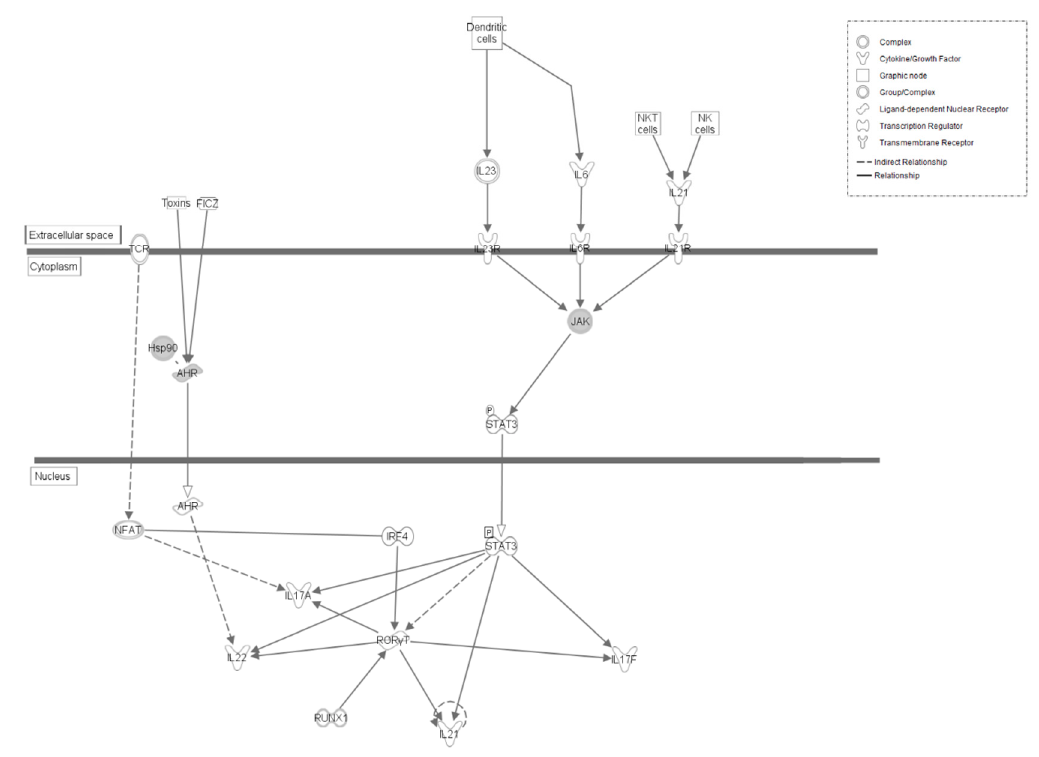
Figure 4. Th17 Activation Pathway in LS line of Japanese quail. Molecular interactions and symbols within the pathway are the same as described in Figure 3.